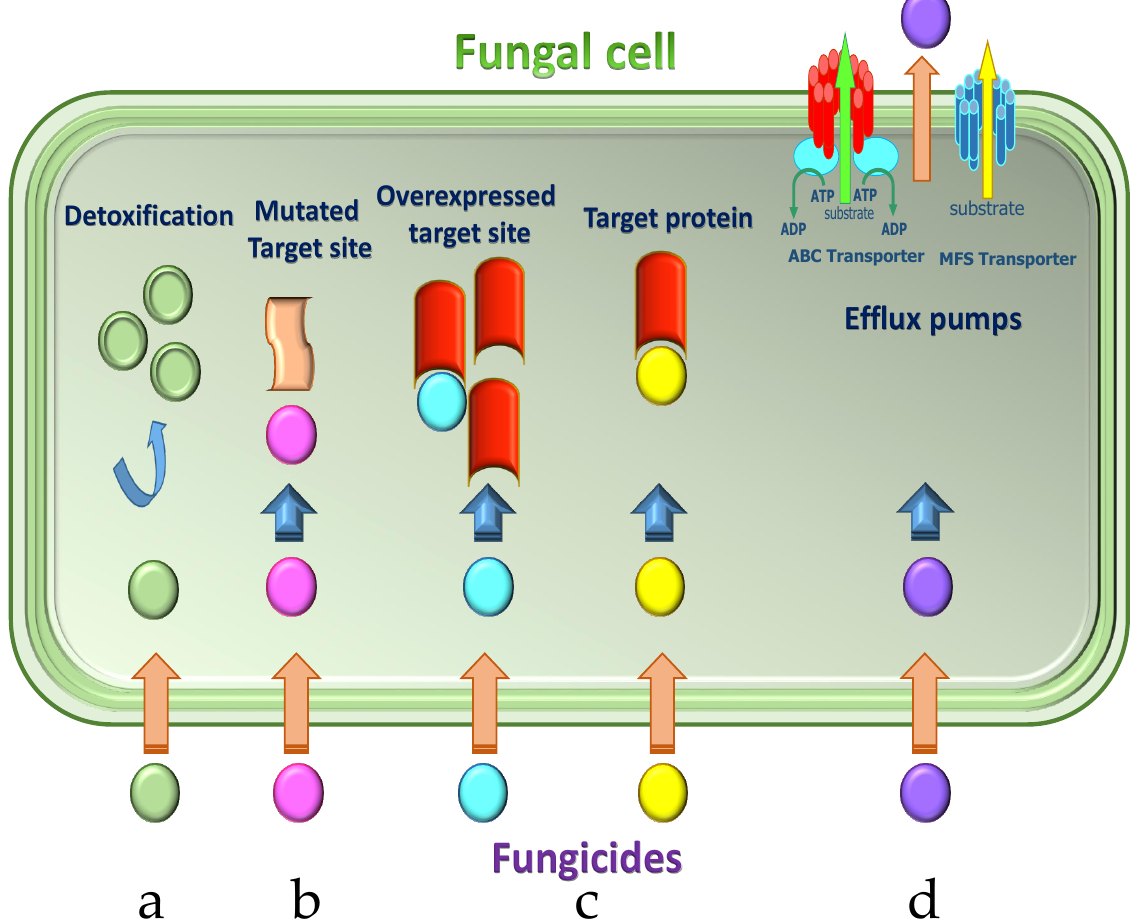
Figure 3. Main mechanisms of acquiring resistance to fungicides in P. digitatum. Mechanisms of resistance to single-site fungicides: ( a ) detoxification of fungicide through metabolic enzymes; ( b ) reduced fungicide binding due to alteration of the target protein; ( c ) overexpression of the target protein; ( d ) efflux pumps removing fungicide out of the cell. Adapted from Lucas et al.